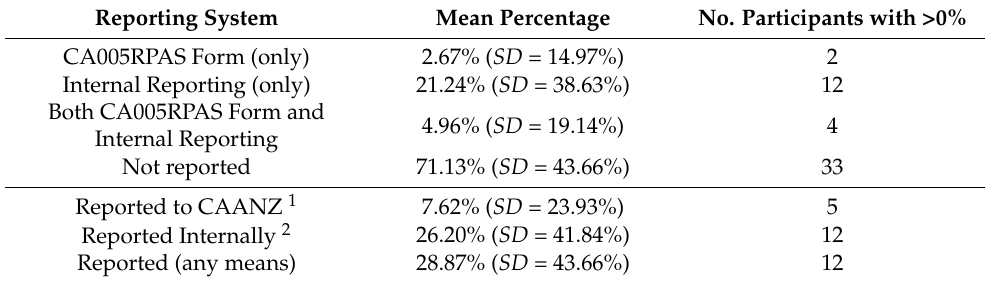
Table 3. Prevalence of reporting systems to report occurrences.